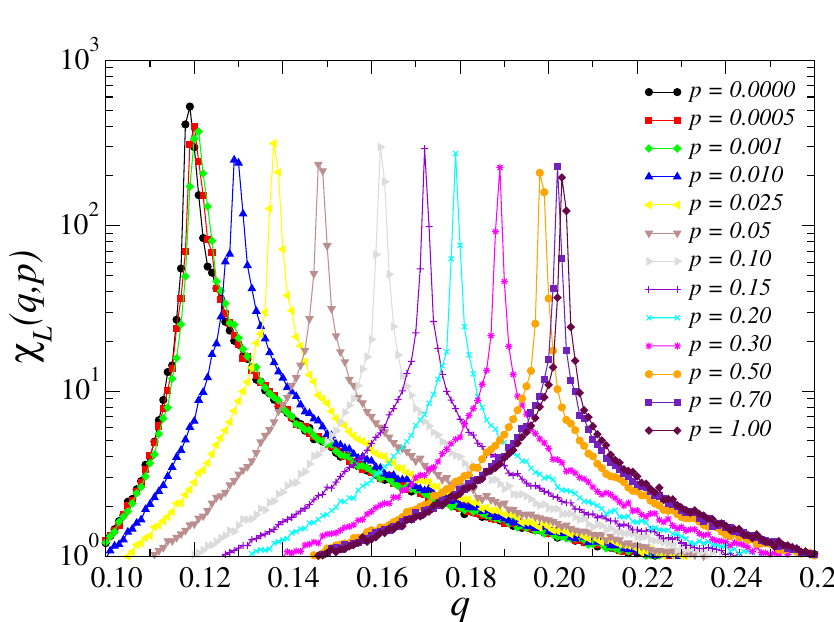
Figure 5. Magnetic susceptibility χ L ( q , p ) as a function of the noise parameter q for several values of the rewiring probability p and L = 140 . The locations of the maximum values of χ L indicate the approximate critical noise q c parameters for each value of p . The error bars are smaller than the symbol size, and the lines are just a guide to the